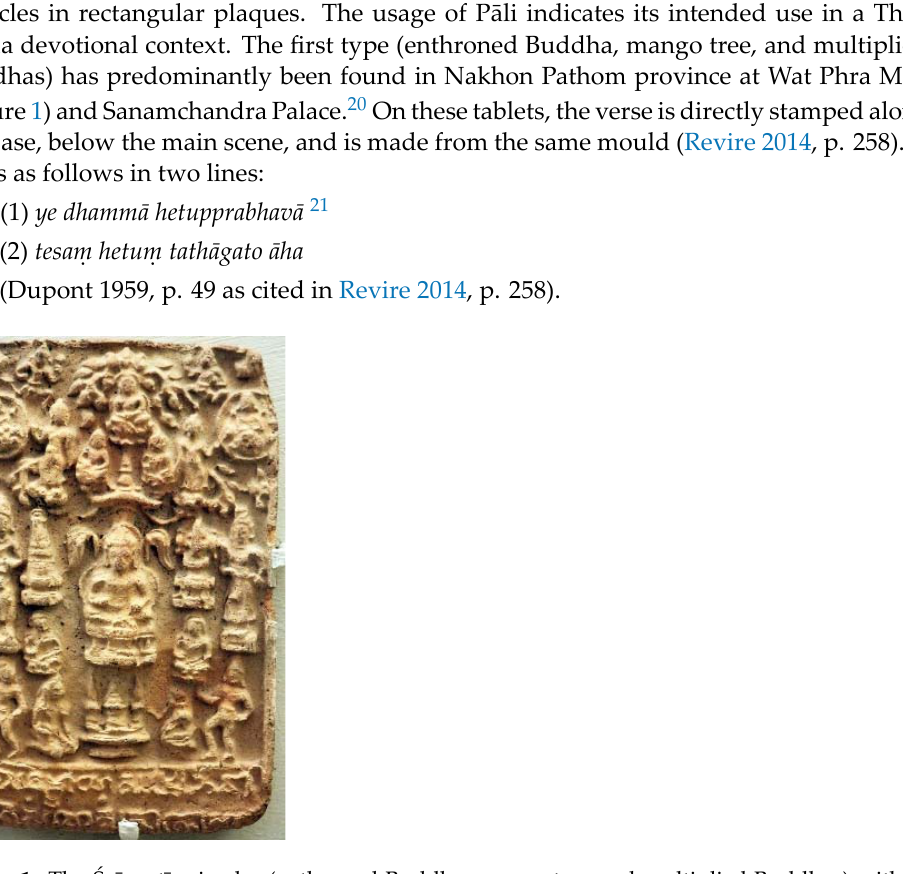
Figure 1. The Ś r ā vast ī miracles (enthroned Buddha, mango tree and multiplied Buddhas) with ye Figure 1. The Śrāvastī miracles (enthroned Buddha, mango tree and multiplied Buddhas) with ye dhamm ā formula. Ca. 8th ‐ 10th centuries CE. Wat Phra Men, Nakhon Pathom province. Moulded dhammā formula. Ca. 8th–10th centuries CE. Wat Phra Men, Nakhon Pathom province. Moulded tablet, clay; h. 14 × w. 8 cm. National Museum, Bangkok (DV 6 ‐ 2). Source: author, 2016. tablet, clay; h. 14 × w. 8 cm. National Museum, Bangkok (DV 6‑2). Source: author,